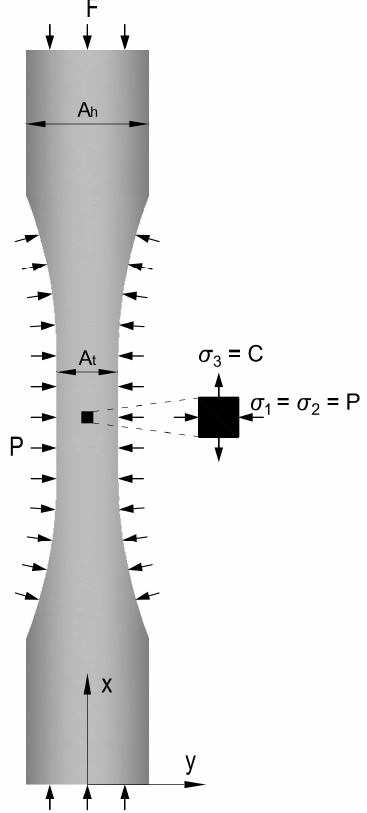
Figure 3. Confined extension test on a dog-bone-shaped rock sample (after Brace, 1964).